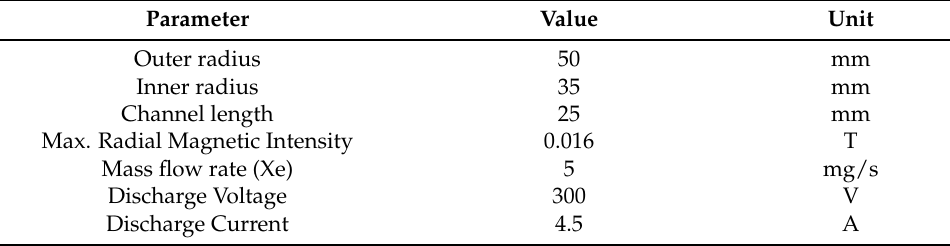
Figure 6. SPT-100 performance: specific impulse and thruster efficiency as function of power (Data from Ref. [40]). The design point is selected in the present study. Table 1. SPT-100: geometry and nominal operative parameters (data from